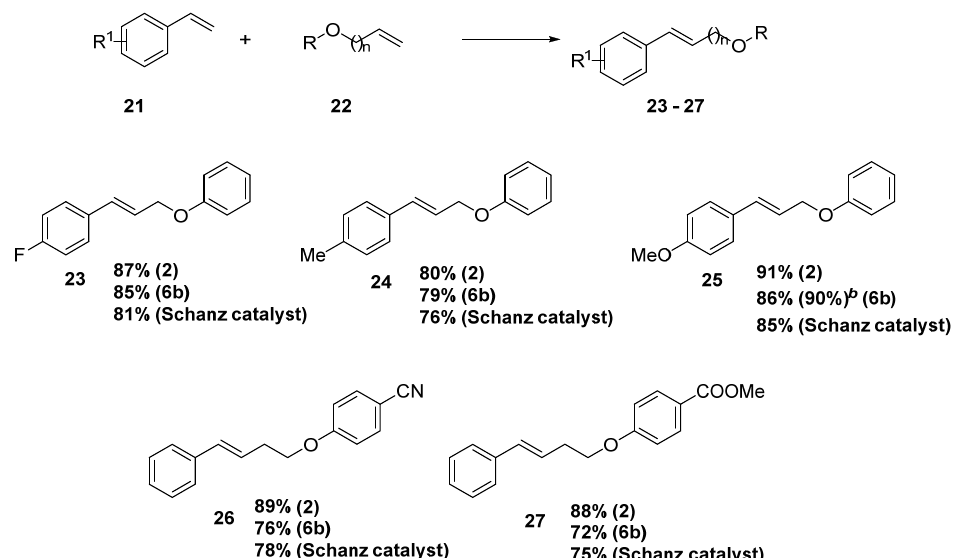
Figure 2. Substrate scope of CM reactions. Substrate 21 (5.0 mmol), substrate 22 (0.5 mmol), DCM (0.5 mL), and [Ru] (2.5 mol%) at 40 °C for 12 h. Isolate yield. b Toluene as solvent at 80 °C for 12 h.